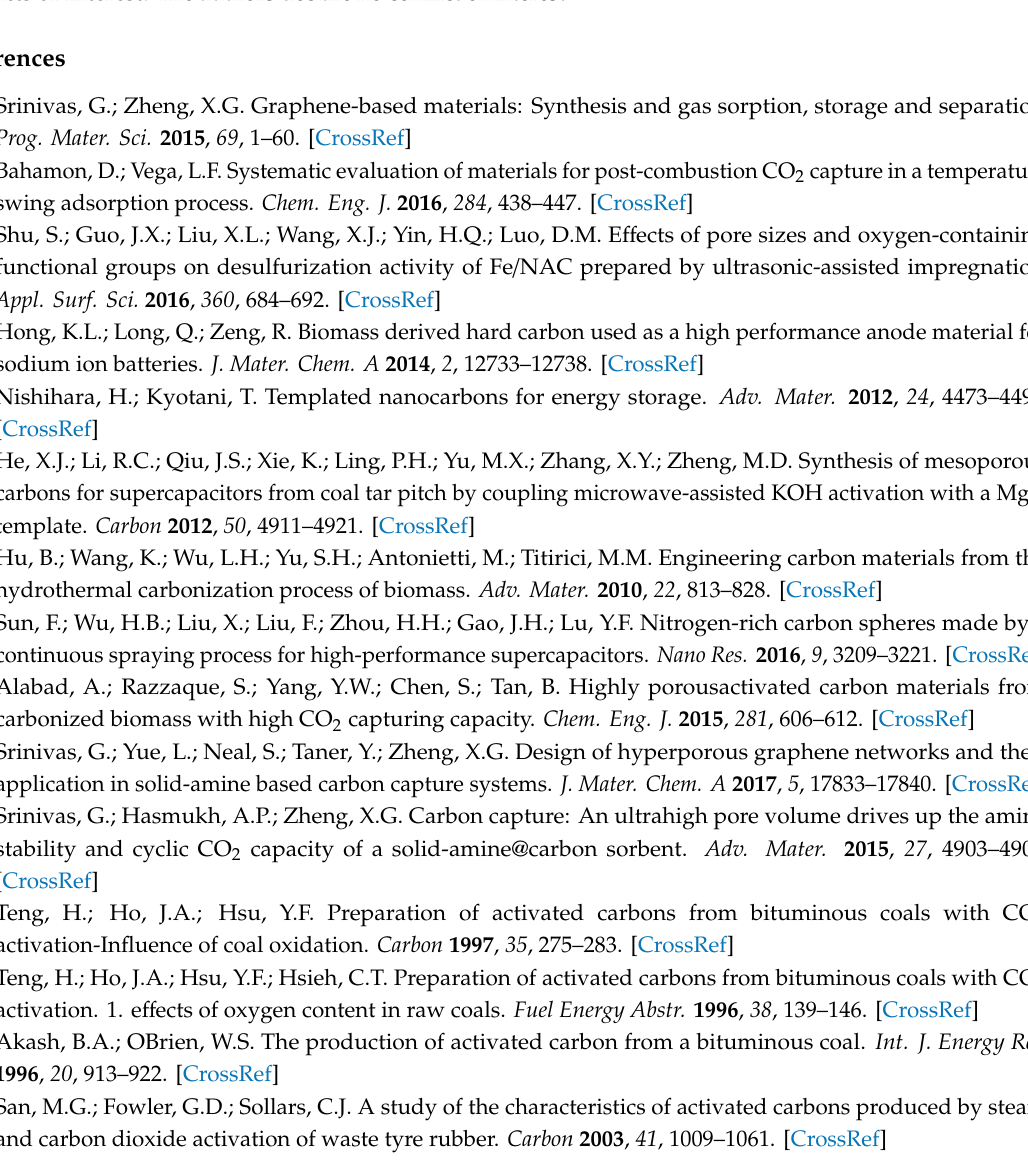
Figure S1: Schematic figure of the fixed bed reactor system for SO 2 adsorption, Figure S2: Raman spectra from chars produced by pyrolysis, Figure S3: XRD profiles from chars produced by pyrolysis, Figure S4: XRD profiles of coal chars at di ff erent burn o ff s during activation ( a ) JX-800; ( b ) JXO-800; ( c ) 3NaJXO-800; Figure S5: Raman spectra of coal chars at di ff erent burn o ff s during activation ( a ) JX-800; ( b ) JXO-800; ( c )